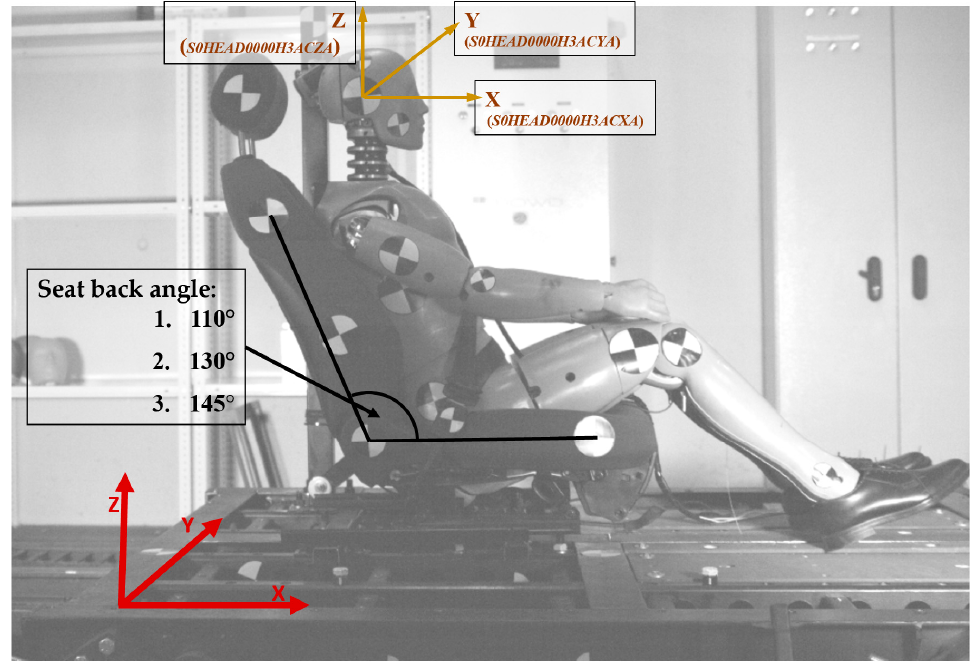
Figure 3. The test station prepared for the tests. The general coordinate system (depicted in red); accelerometers location with channels named according to ISO/TS 13,499 (depicted in gold); seatback angle considered in the experiments (depicted in black).